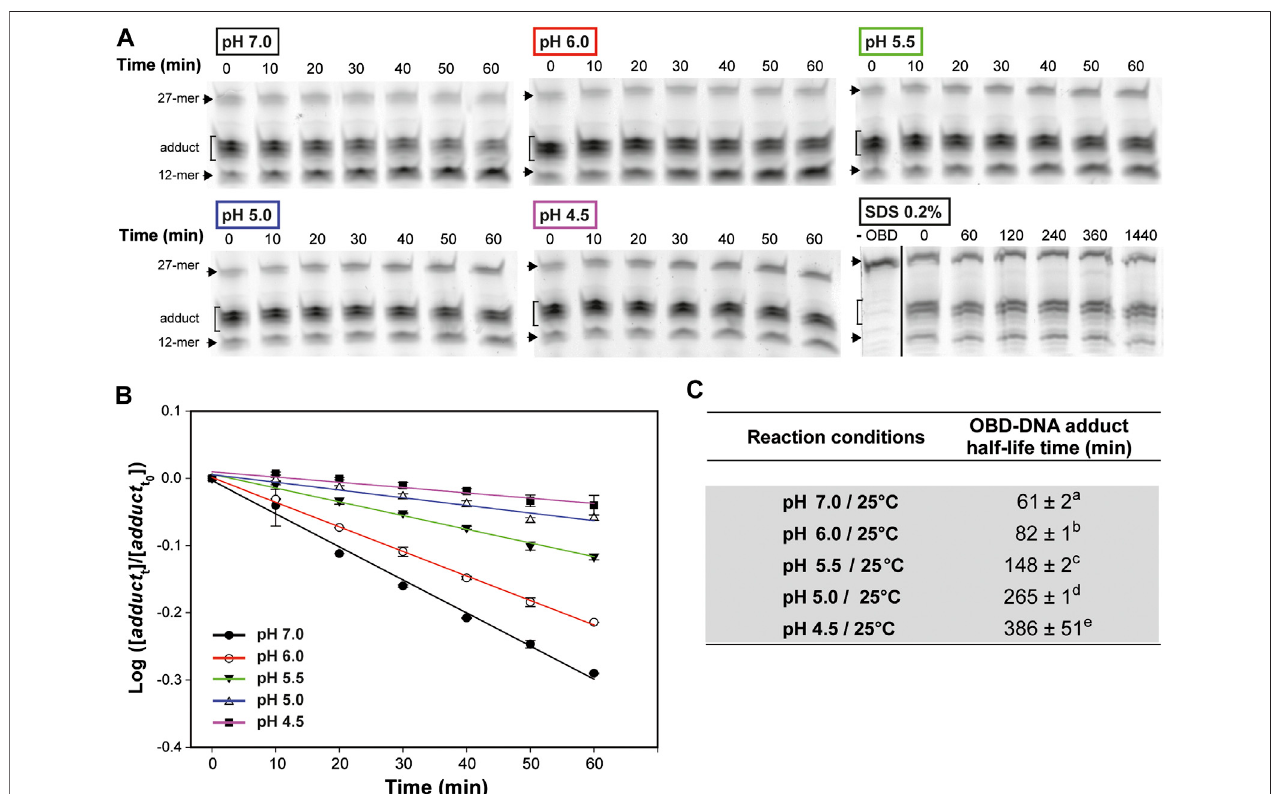
FIGURE 4 | OBD-DNA adduct stability at different pHs. (A) Gels showing the effect of pH on the time course of the adduct-hydrolysis reaction. The reaction mixturescontaineda1.5:1 molarratioofOBD tothe3 ′ - fl uorescently labeled 27-meroligo substrate and wereprepared inbuffer 7. After2 minofincubation at 25 ° C,the endonuclease reaction was stopped with 10 mM EDTA before diluting the mixtures in buffer 7, 6, 5.5, 5 or 4.5 for 1-h incubation at the same temperature. Several aliquotsweretakenevery10 minandanalyzedin20%PAA-ureagels.Agelshowingtheeffectofdenaturingtheproteinonthestabilityoftheadductisalsoshown. Inthiscase,theendonucleasereactionwasperformedinbuffer7for2 minat22 ° C,andthenthemixturewasdilutedinbuffer7,treatedwith0.2%SDSandincubatedat thesametemperaturefor24 h.Severalaliquotsweretakenattheindicatedtimesandanalyzedin20%PAA-ureagels.Acontrollane(-OBD)showingthemigrationofthe fl uorescent 27-mer substrate is included. The dividing line indicates grouping of different parts of the same gel. (B) Kinetics of the hydrolysis of the OBD-DNA adduct at differentpHs.Thelogarithmoftheratiobetweenthefractionofadductateachofthetimeintervalsanalyzed( adduct t )andtheinitialfraction( adduct t0 )wasplottedagainst time, and the experimental data were fi tted to Eq. 2 by linear regression. The OBD-DNA adduct half-life time was calculated from the slope of the regression curve according to Eq. 3 . Plots display the adduct decay curves obtained from at least fi ve independent experiments for each pH, with the symbols and vertical bars representingthemeanandstandarddeviation, respectively. (C) Tableshowingtheadducthalf-lifetime calculatedfrom atleast fi veindependentexperimentsperformed under the indicated reaction conditions. The values are expressed as mean ± SD. Values with different superscript letters were signi fi cantly ( p < 0.05) different.